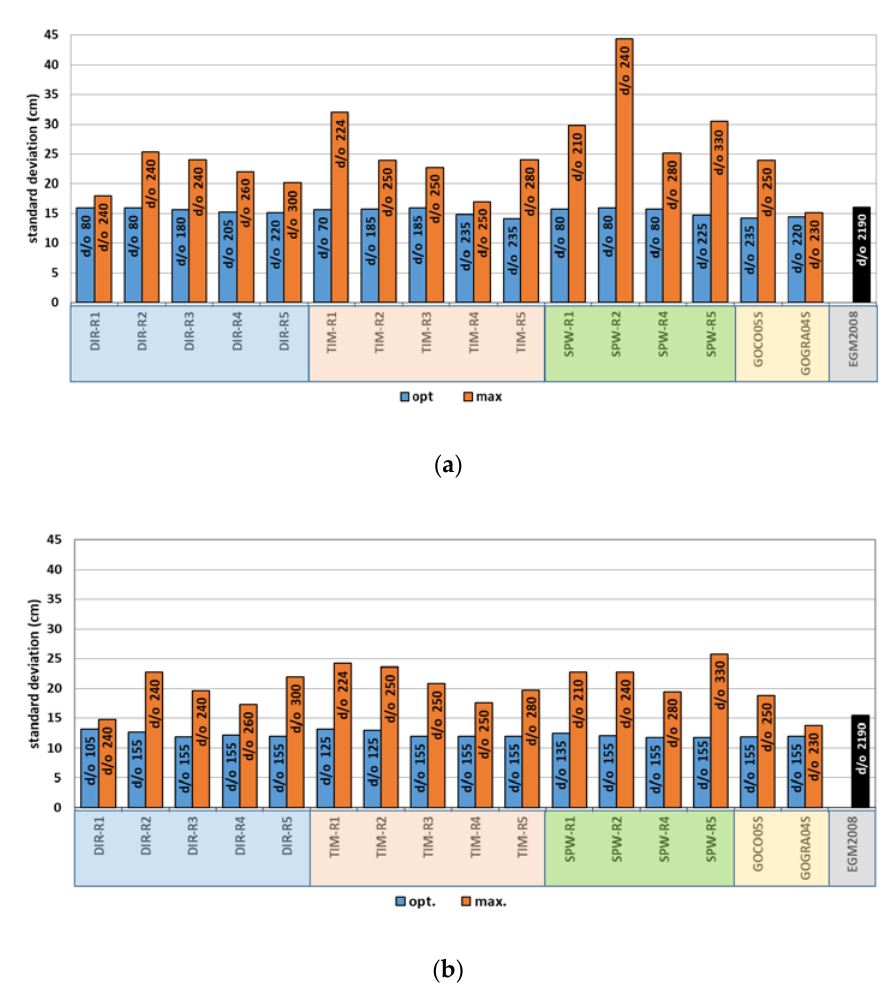
Figure 6. Standard deviations of the geoid height residuals in cm (note that the geoid heights ( N enh . derived from the enhanced GGMs over optimum (blue bar) and maximum (orange bar) degrees for ( a ) the first dataset; ( b ) the second dataset.